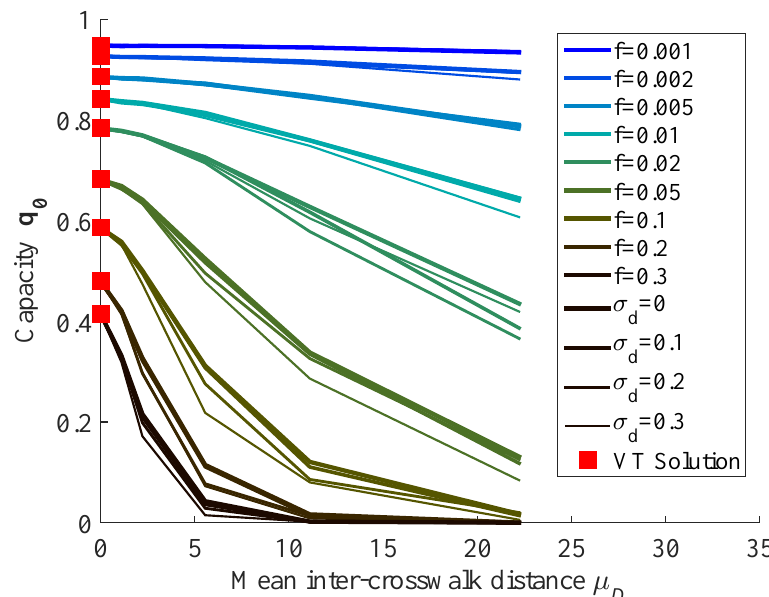
Figure 1. Capacities for different inter-crosswalk distances .The capacity decrease as function of the increasing mean distance between two crosswalks. Different colors indicate different pedestrian flows; different widths indicate different variations in in inter-crosswalk distance. The red squares for µ D =0 indicate the variational theory (VT) solution for continous crossings from Daganzo and Knoop